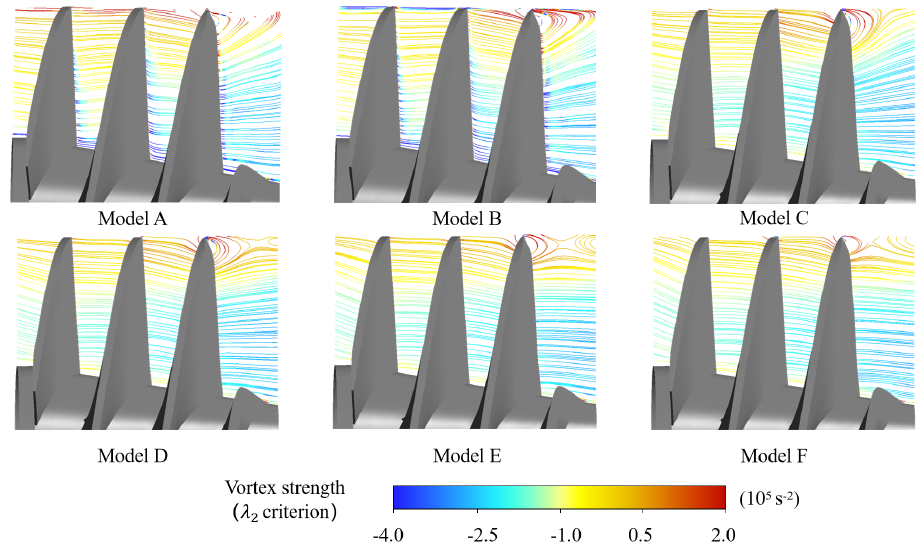
Figure 15. Streamlines with vortex strength ( λ 2 criterion) for all